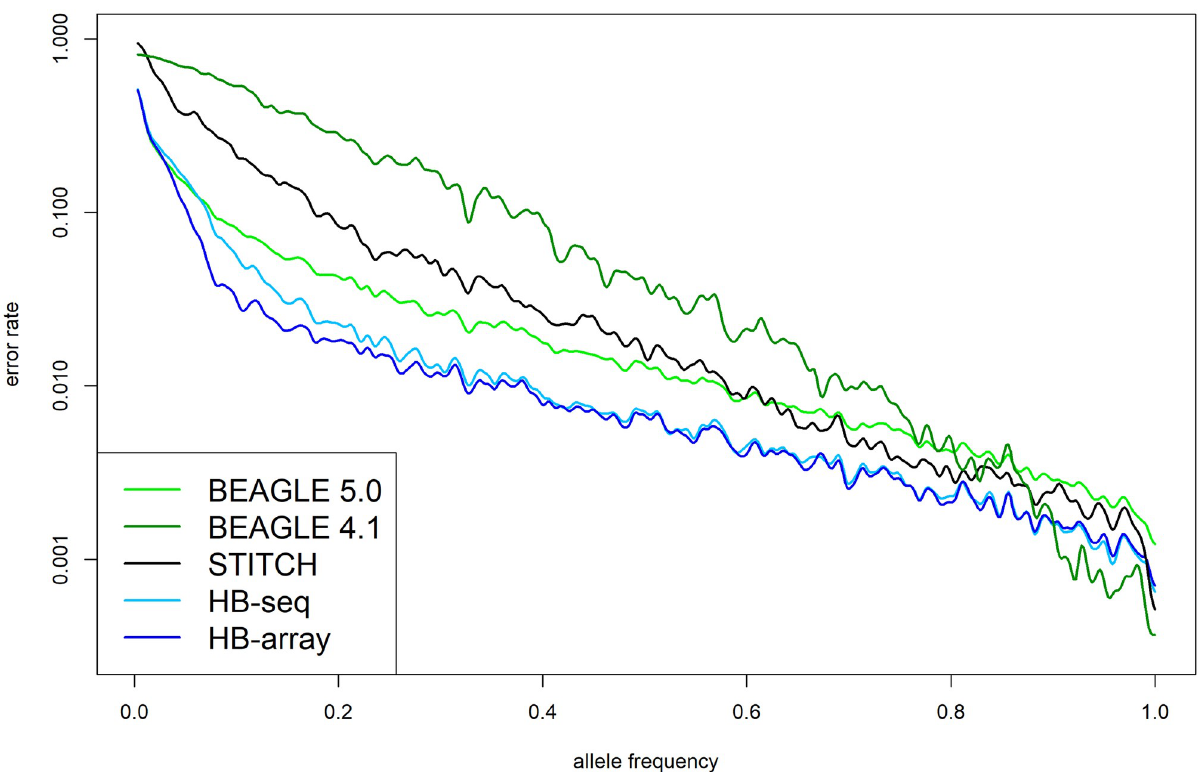
Fig 2. Discordance rates of the imputed sequence data to the 600k array data depending on the used imputation pipeline and the allele frequency of the given variant.